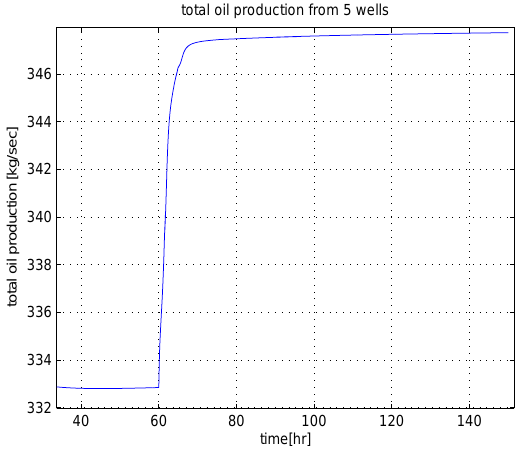
Figure 12: Total oil production with hill climbing op- timization turned ’ON’ at t = 60 hours Without any optimization, the total oil production was about 332 kg/sec as shown in Figure 5. So the hill climbing optimization caused an increase in the total oil production by about 15 kg/sec. When expressed in percentage, the oil production was increased by about 4.5%, which is very much similar to what was obtained with optimization using solver from MATLAB opti- mization toolbox.